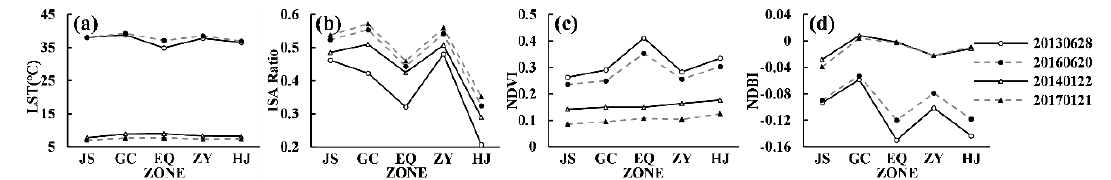
Figure 8. Mean value of LST ( a ), ISA ratio ( b ), Normalized Difference Vegetation Index (NDVI) ( c ), and Normalized Difference Built Index (NDBI) ( d ) in different zones.